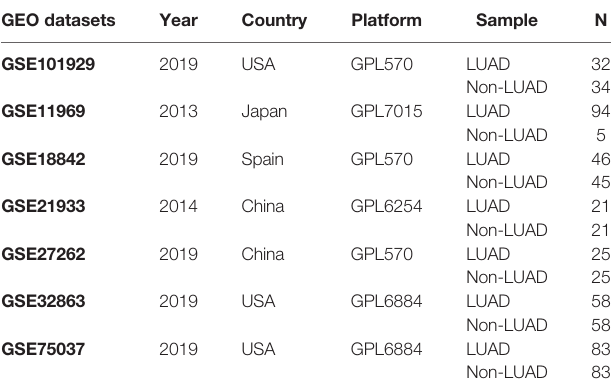
TABLE 2 | Information of selected GEO series datasets.